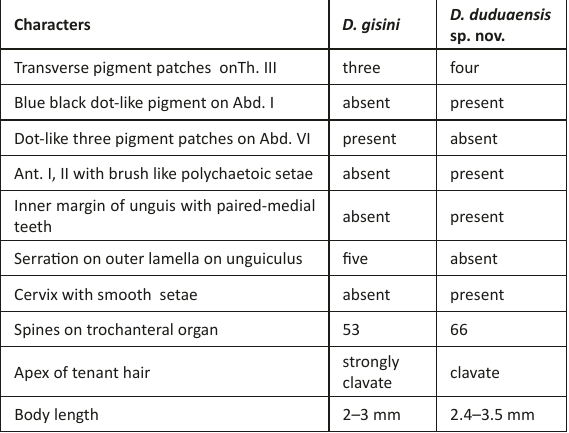
Table 1. The differences between D . gisini, and D. duduaensis sp.